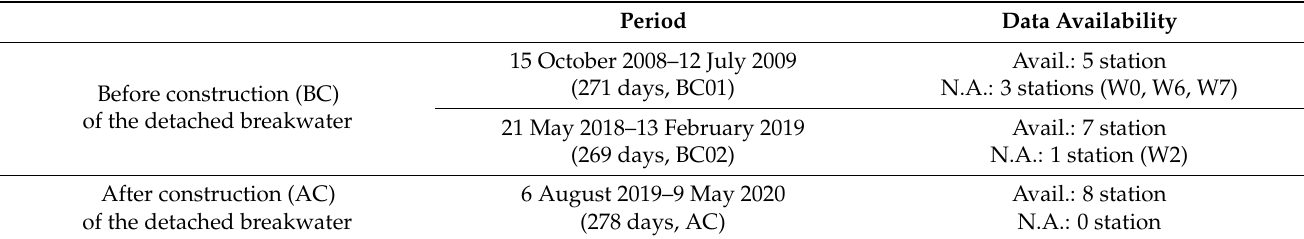
Table 2. List of the observation periods.